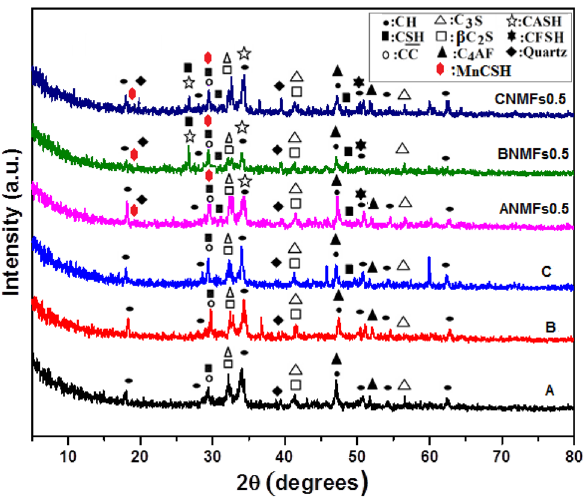
Figure 14. XRD patterns of hardened composites made from mixes (A–C), and nanocomposites made from mixes (ANMFs0.5–CNMFs0.5) at 28 days of hydration.